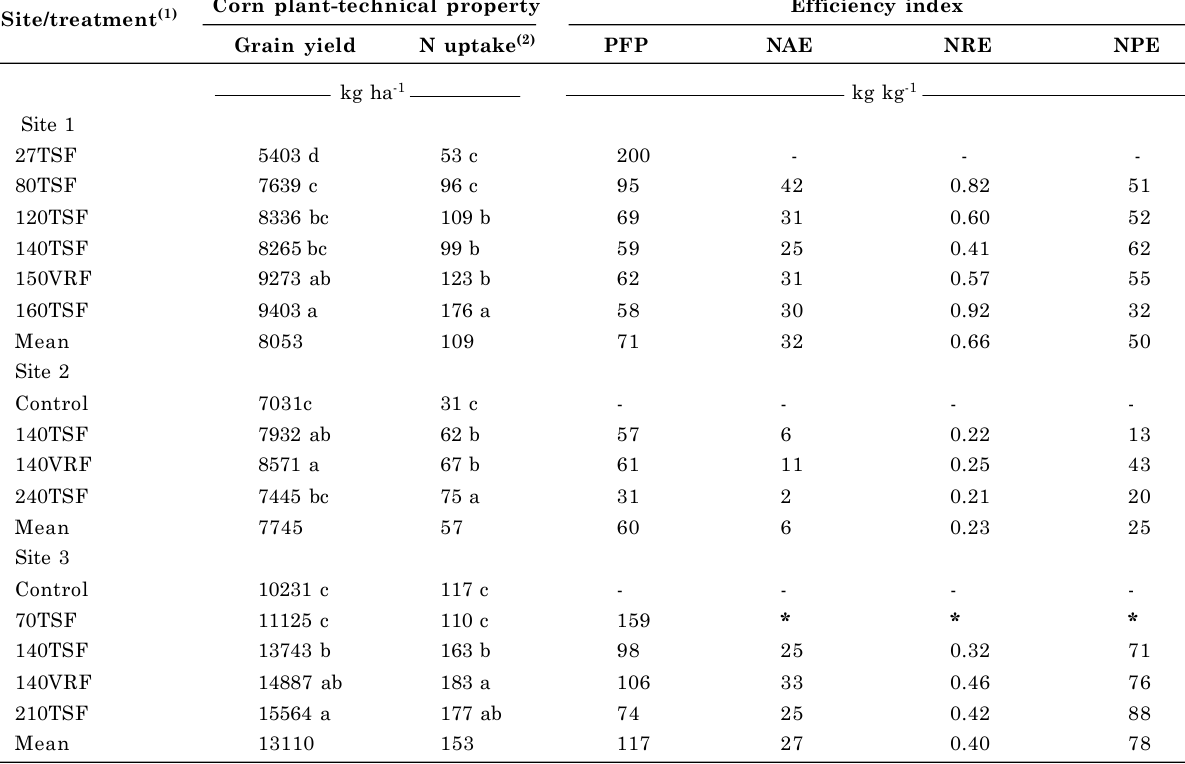
table 3. The average PFP for sites 1 and 3 was